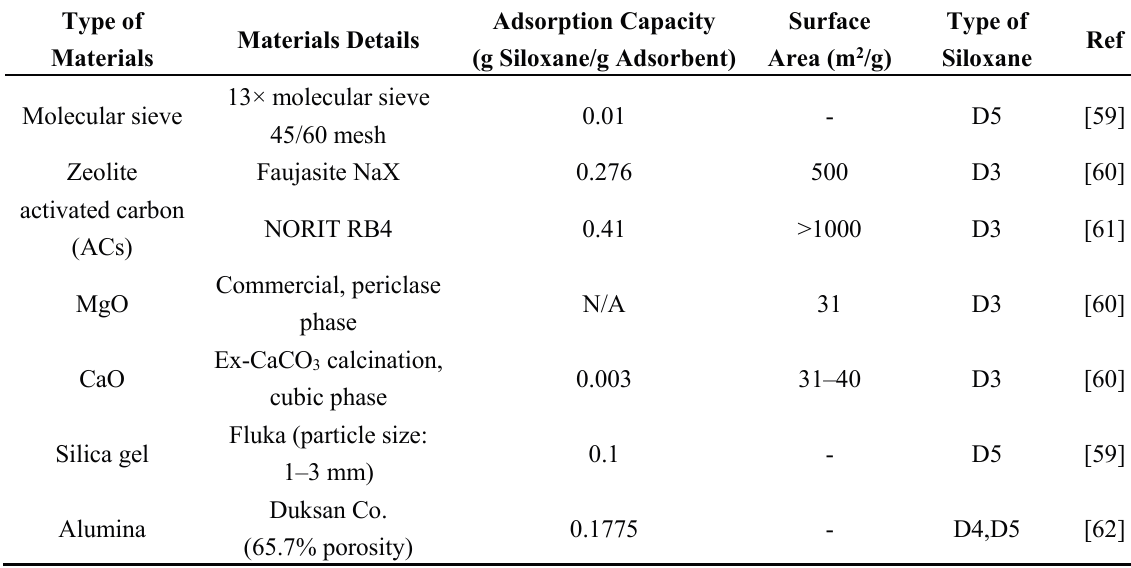
Table 4. Siloxane adsorbents in the